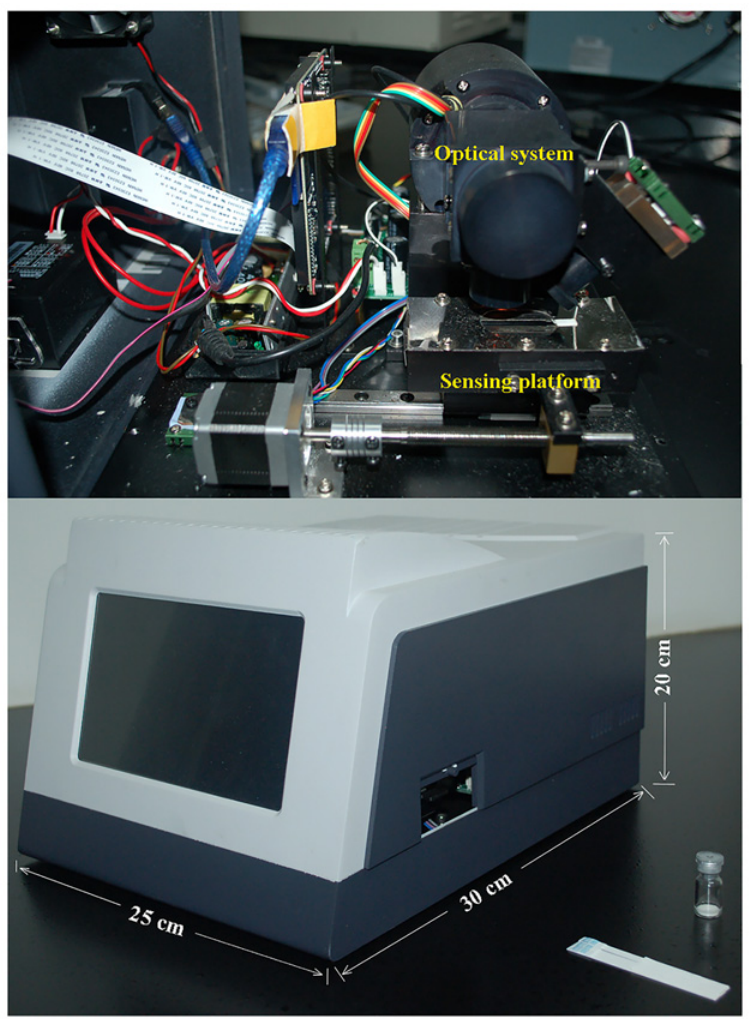
Fig 2. The external and inner view of CTRFIA